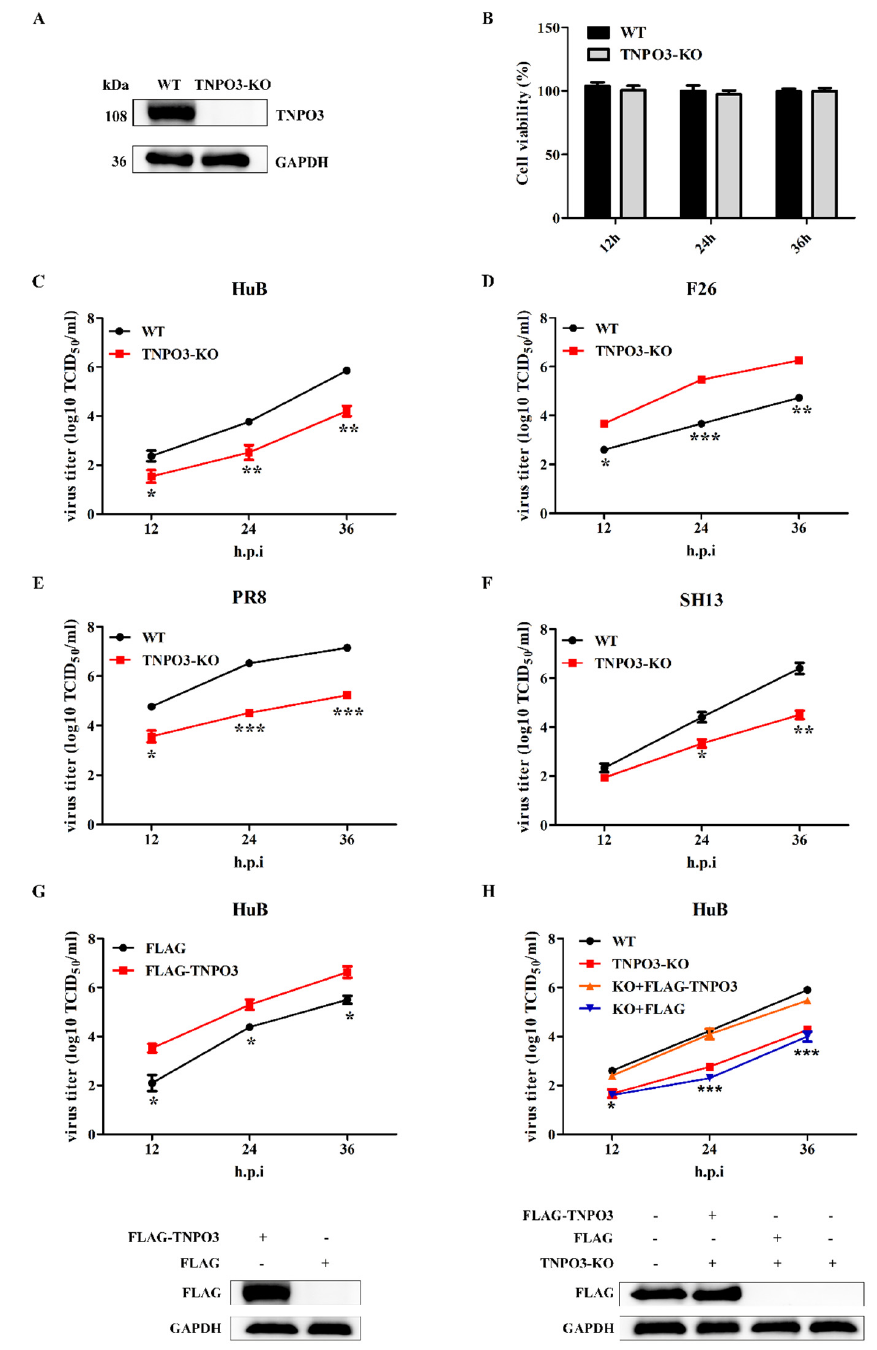
Figure 1. TNPO3 is involved in the replication of IAV. ( A ) Western blot detection of the TNPO3 in knockout (KO) and wild-type (WT) cells. ( B ) Cell viability was determined using CCK-8 detection. ( C – F ) Assessing the effects of TNPO3 knockout on IAV replication with the TCID 50 assay. WT and TNPO3-KO cells were infected with HuB/H1N1, F26/H1N1, PR8/H1N1, and SH13/H9N2 at MOI of 0.01, respectively. ( G ) Assessment of the effect of overexpression of TNPO3 on HuB/H1N1 virus (MOI = 0.01) replication by the TCID 50 assay. ( H ) TNPO3 knockout cells were complemented with wild-type TNPO3, and then challenged with HuB/H1N1 virus (MOI = 0.01). FLAG-TNPO3—overexpression vector of 3 × FLAG-CMV-TNPO3. FLAG—control vector of FLAG. Virus titers were determined by TCID 50 assay on MDCK-NBL-2 cells (mean ± SD of three independent experiments; *, p < 0.05; **, p < 0.01; ***, p < 0.001; two-tailed Student’s t-test). 2.2. TNPO3 is not Required for the IAV Attachment and the Expression of Sialic Acid Receptors.